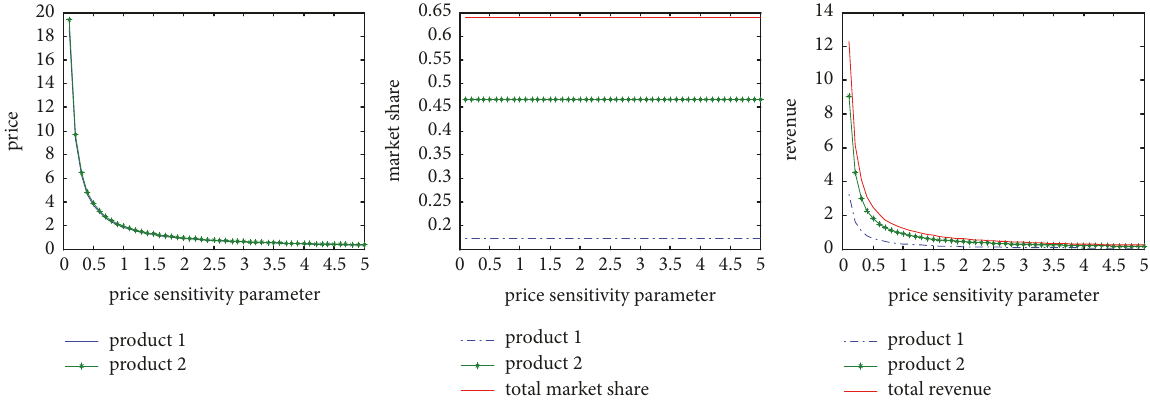
Figure 7: The influence of the price sensitivity parameter on the optimal